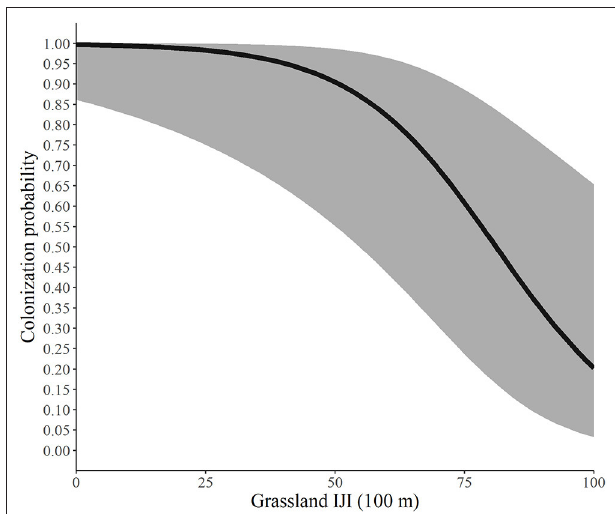
FIGURE 4 | Predicted probability of colonization by monarchs as a function of the interspersion of grassland at the 100-m spatial scale, Iowa, 2006-2017. The solid line represents the predicted probabilities and the gray region is the 95% confidence envelope. Predictions are based on the model Psi(GRS1KPS + WOD200PLAND) Gamma(WOD200PLAND + GRS100IJI) p(dapl.density +